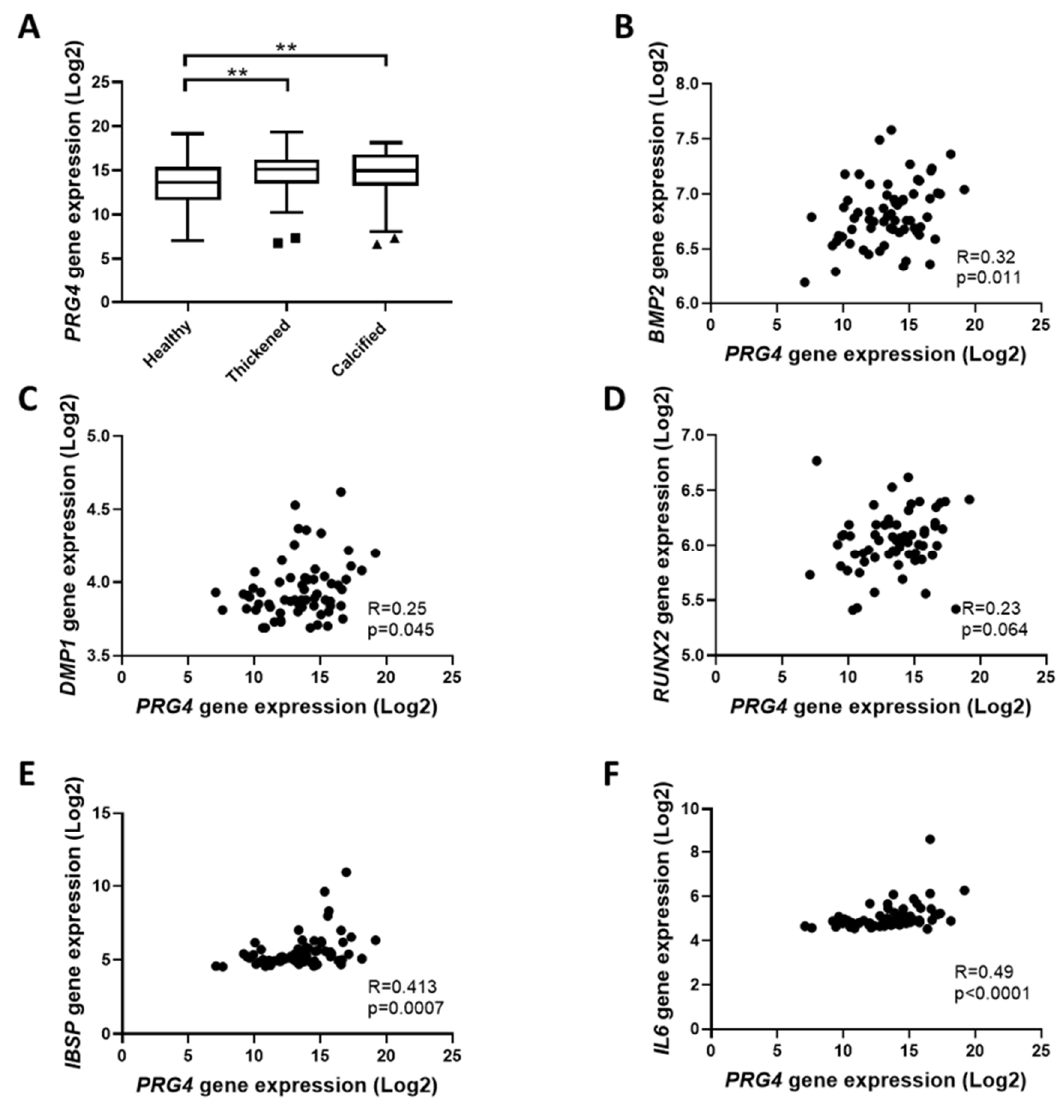
Figure 1. Proteoglycan 4 (PRG4) is overexpressed in the thickened and calcified regions of the aortic valve and associates with calcification related genes: ( A ) Proteoglycan 4 (PRG4) expression from N = 64 patients in healthy, thickened, and calcified regions of the same valve. ( B – F ) PRG4 mRNA association in healthy regions (Spearman correlation coefficient; N = 64) with ( B ) bone morphogenetic protein 2 (BMP2), ( C ) dentin matrix acidic phosphoprotein 1 (DMP1), ( D ) runt‐related transcription factor 2 (RUNX2), ( E ) integrin binding sialoprotein (IBSP), and ( F ) interleukin 6 (IL6). Statistical significance was determined using a 1‐way ANOVA repeated measurements followed by a Tukey post hoc multiple comparisons analysis; ** p < 0.01.